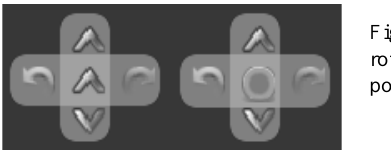
Figure 8. Globe tilt and rotate controls pre and post expert